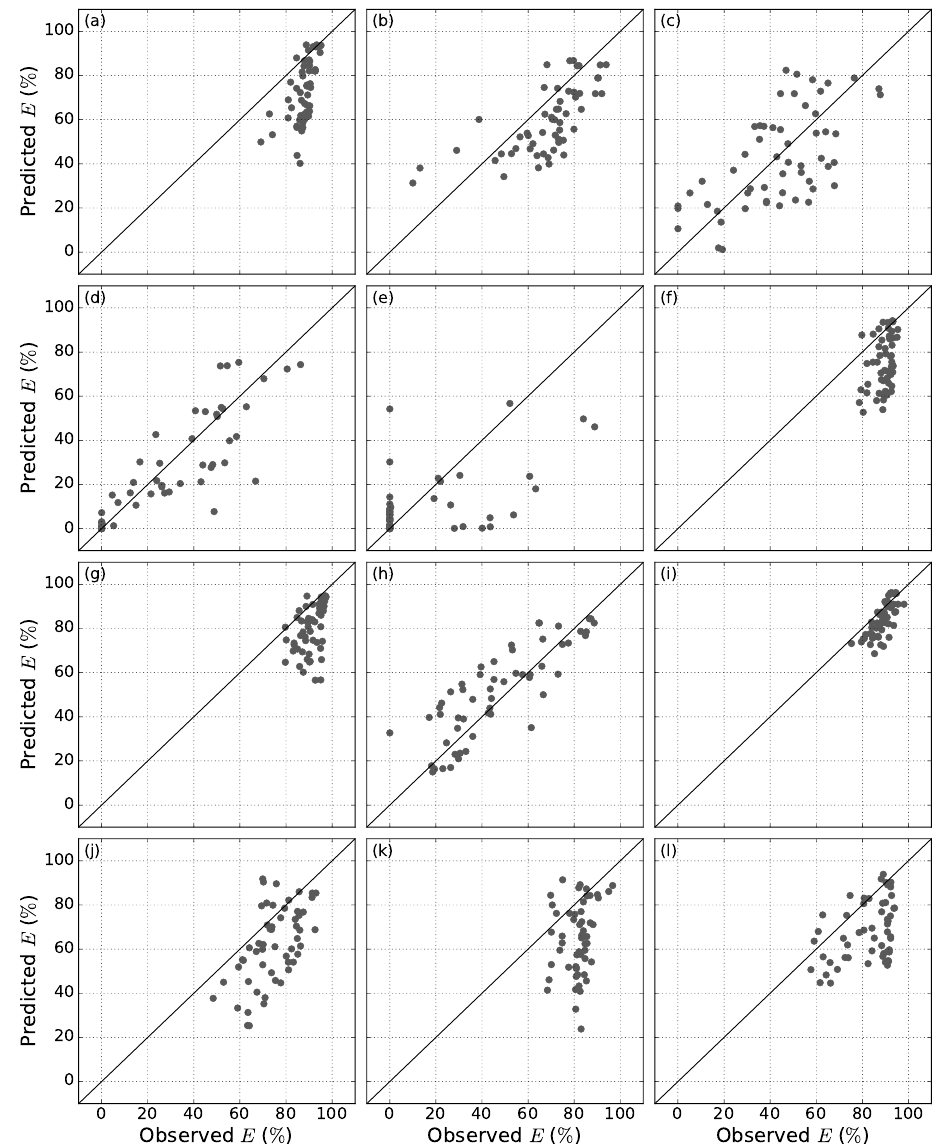
Figure 9. The observations of the effective confidence ( E ) against its predictions at the 12 selected stations across the bay (noted in Figure 7b). The solid line is the diagonal